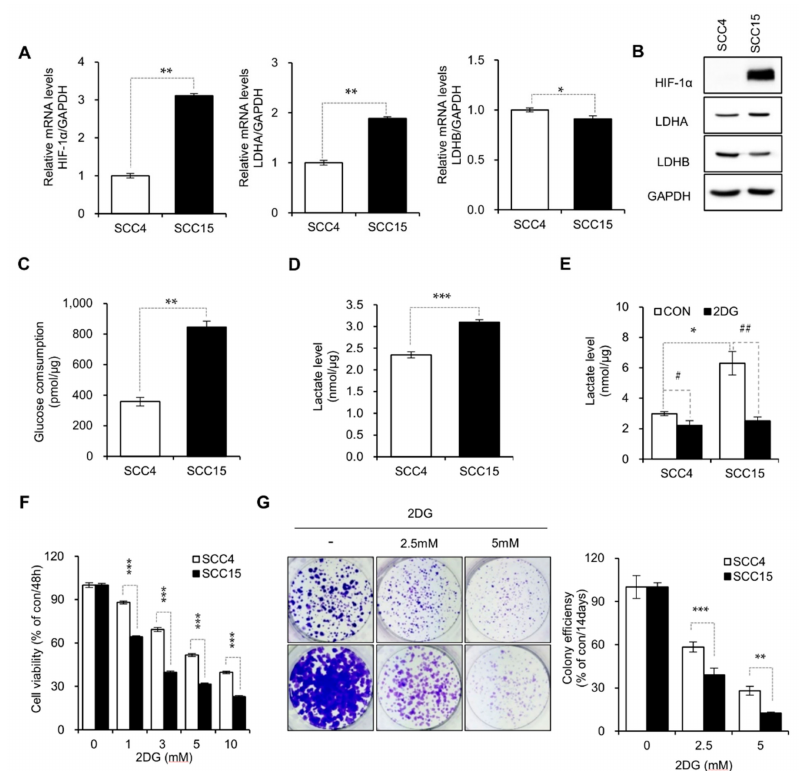
Figure 1. SCC15 cells are susceptible to 2DG treatment. ( A ) Quantitative real-time PCR measuring the levels of the indicated genes. GAPDH was used for Ct value normalization. Statistical significance was determined using the Student’s t -test. * p < 0.05; ** p < 0.01. Error bars show mean ± SD ( n = 3). ( B ) Western blot analysis for the expression of LDHA, LDHB and HIF-1 α proteins in SCC4 and SCC15 cells. GAPDH was used as a loading control. ( C ) Glucose consumption levels in SCC4 and SCC15